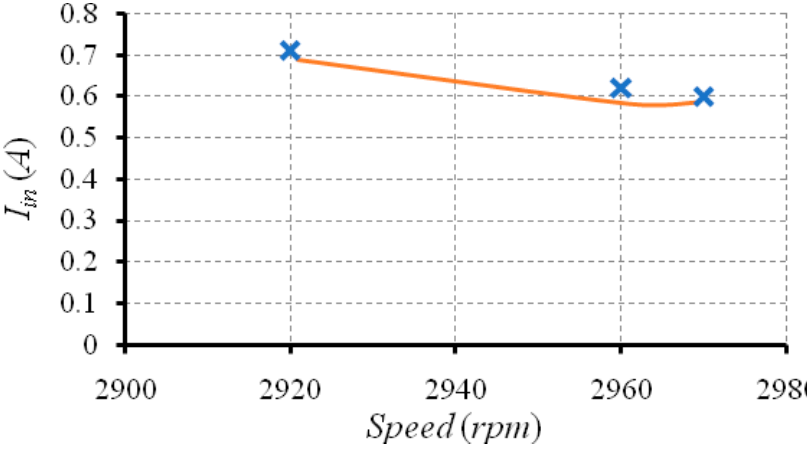
Figure 17. current–speed characteristics of six-phase motor ( − simulation, x experimental).